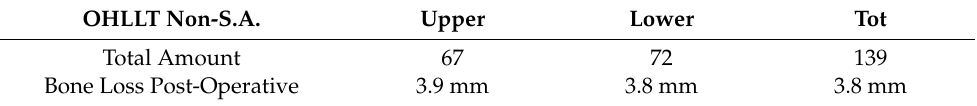
Table 5. Bone loss post-operative (t 1 ) for implants with non-surgical approach (non-S.A.). OHLLT Non-S.A. Upper Lower Tot Total Amount 67 72 139 Bone Loss Post-Operative 3.9 mm 3.8 mm 3.8 mm